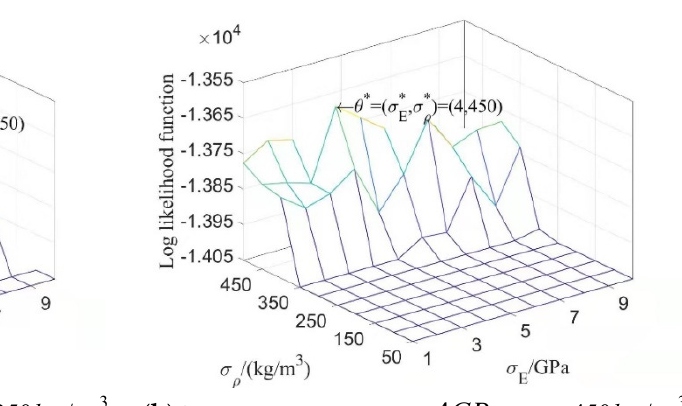
Figure 8. Log likelihood function of 8-dimensional kernel density distribution function of the first 8 orders’ natural frequencies when both E and